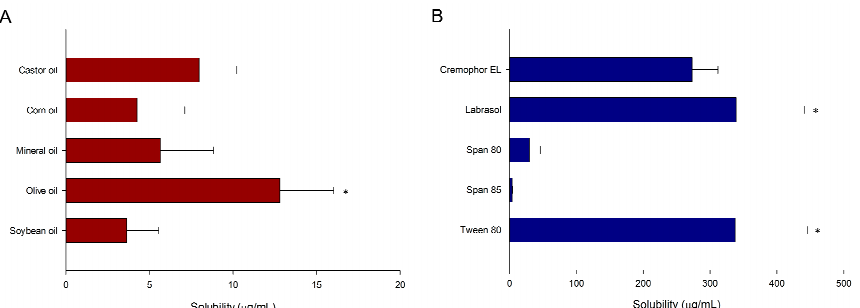
Figure 1. Solubility (at 25 °C) of methotrexate in various oils ( A ) and surfactants ( B ). Data are presented as mean ± SD ( n = 3). * p < 0.05.